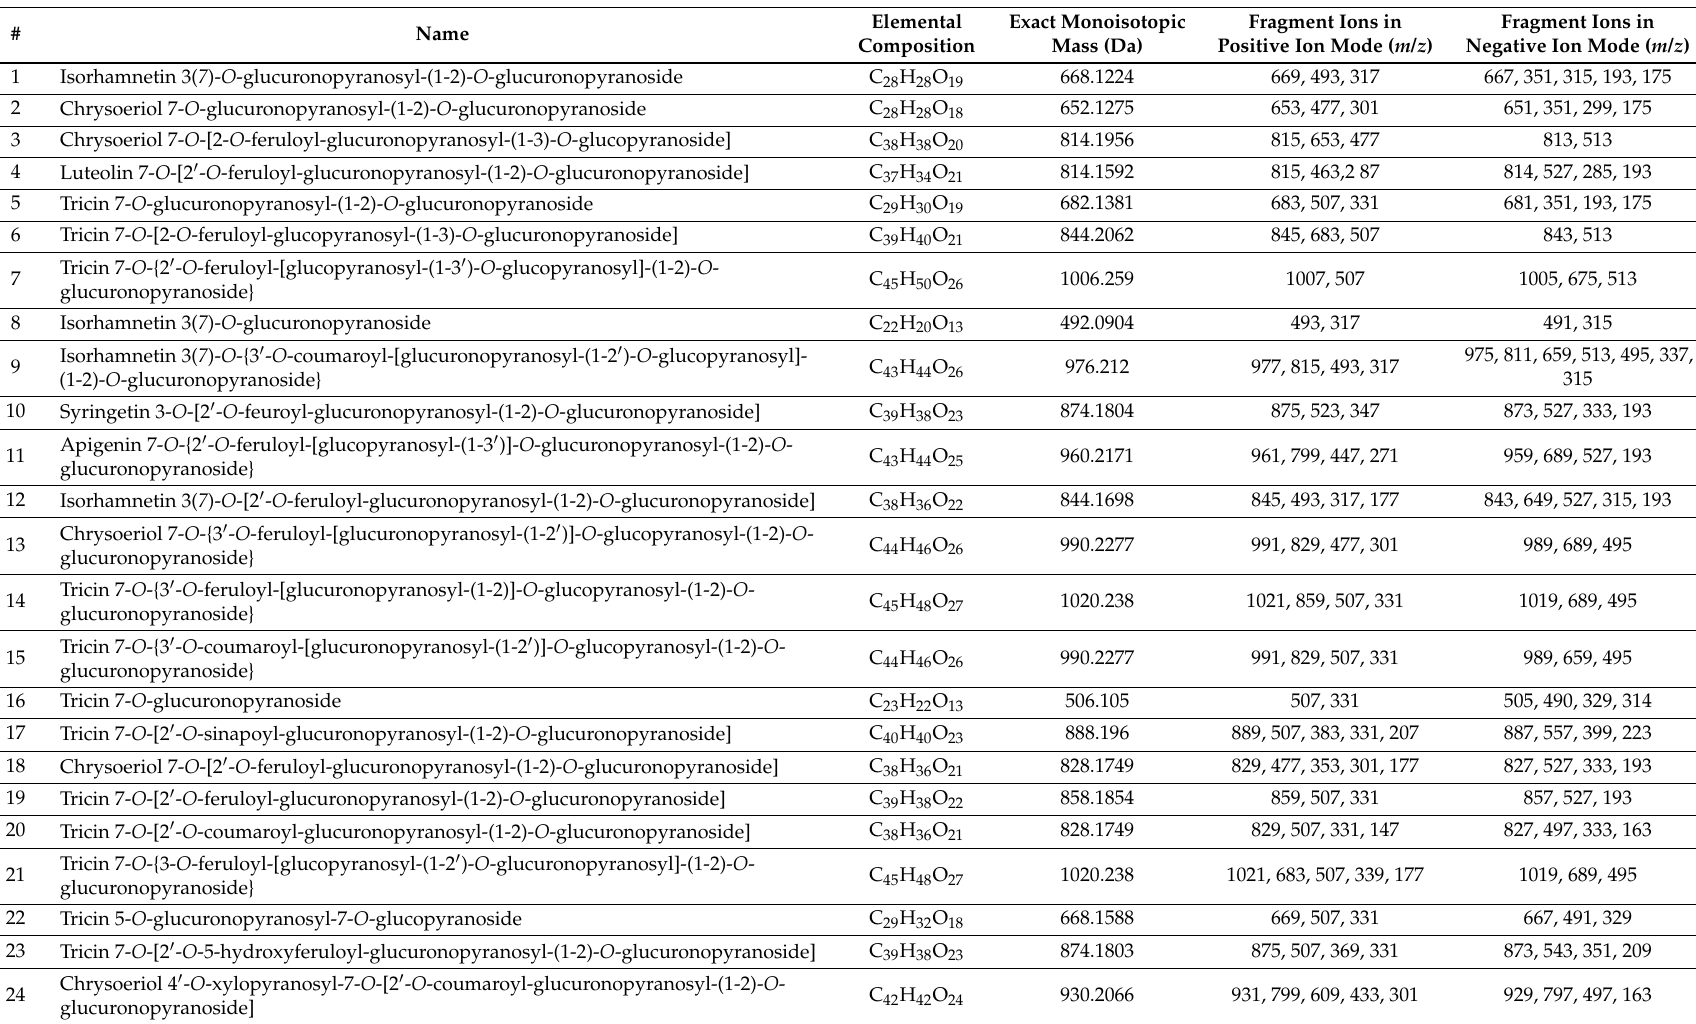
Table 1. Flavonoid glycosides tentatively identified in Axyris amaranthoides